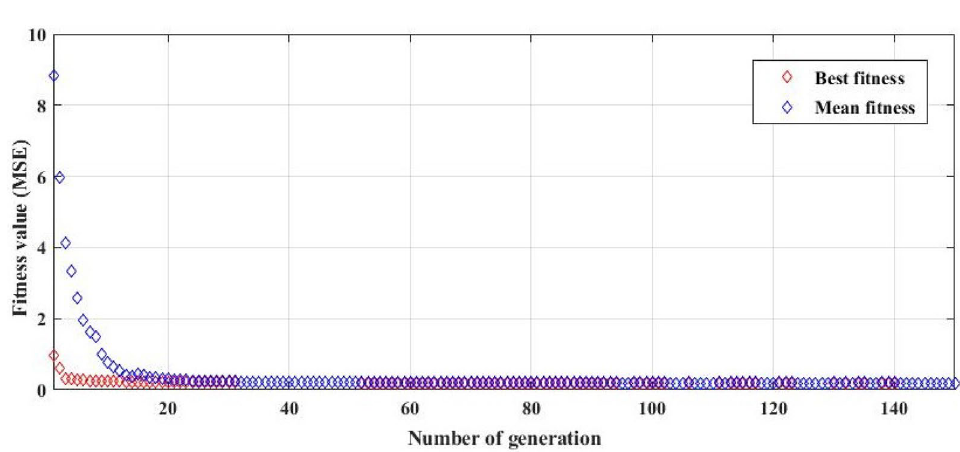
Figure 8. Convergence curves of the average fitness and the best fitness of evolution generation for optimizing the initial weights and biases of the